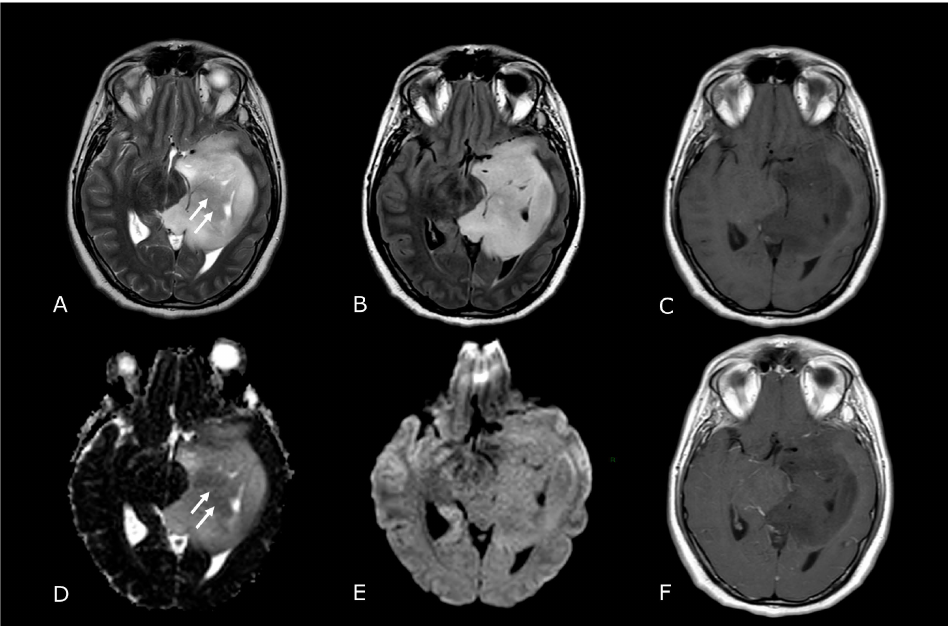
Figure 1. Morphological sequences: tumor cellularity. Morphological sequences: tumor cellularity. Left deep temporo-mesial WHO grade 3 IDH-mut diffuse astrocytoma. Lesion is hyperintense on T2w and FLAIR images ( A , B ), isointense on DWI ( E ), with areas of lower T2 signal intensity and diffusion restriction (white arrows in ( A , D ) that reflect hypercellular and probably more anaplastic tissue. No contrast enhancement is detectable on post-contrast T1w image ( F ) compared to pre-contrast image ( C